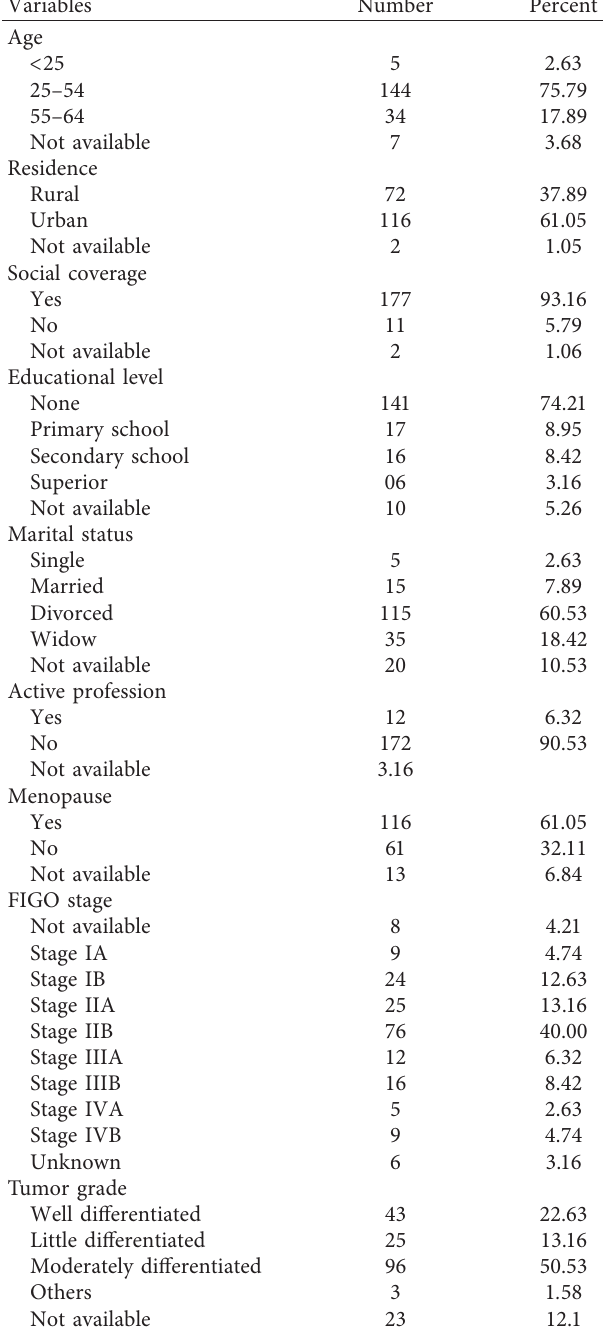
Table 1: Sociodemographic and clinical characteristics of